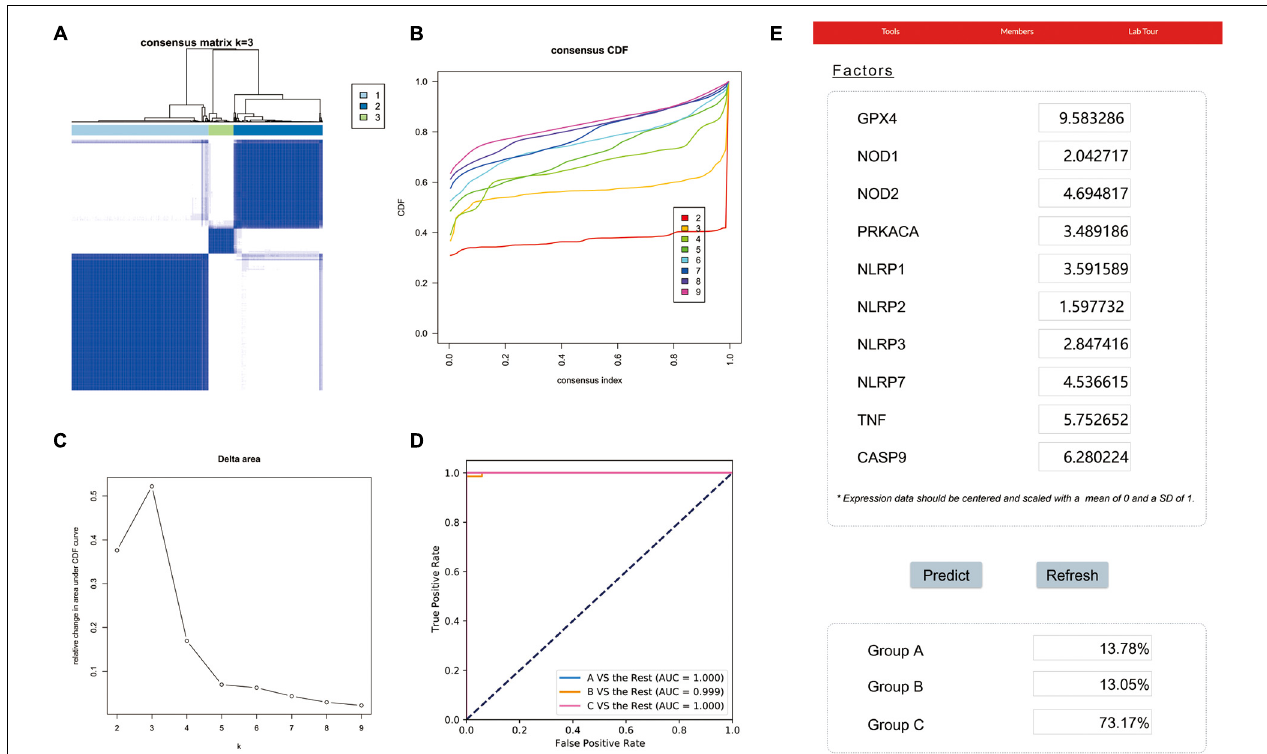
FIGURE 2 | The construction of pyroptosis-related LUAD subtypes in the TCGA cohort. (A) Three pyroptosis-related molecular subtypes were generated via unsupervised consensus clustering. (B) The empirical cumulative distribution function (CDF) plots revealed the consensus distributions for each k. (C) The delta area score displayed the relative growth in cluster stability. A classification CatBoost model was established based on 10 key pyroptosis-related genes. (D) Showed receiver operating characteristic curves (ROCs) of CatBoost. (E) An example of the web-based